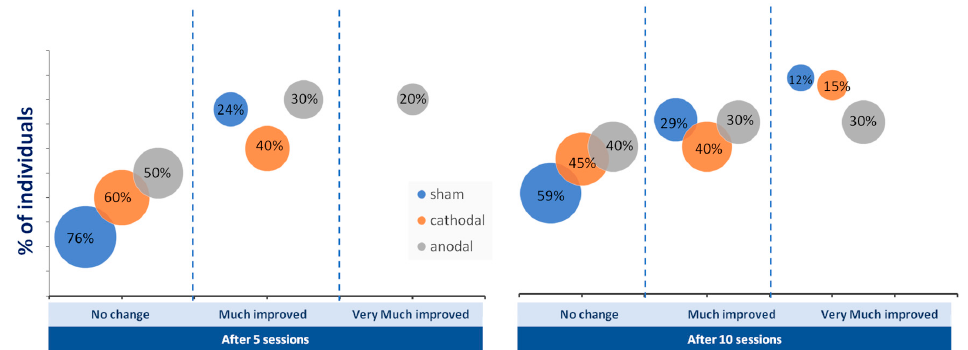
Figure 4. Percentage of individuals who achieved no change (below five points on Fugl-Meyer Assessment of Upper Extremity), much improvement (above five points), and very much improvement